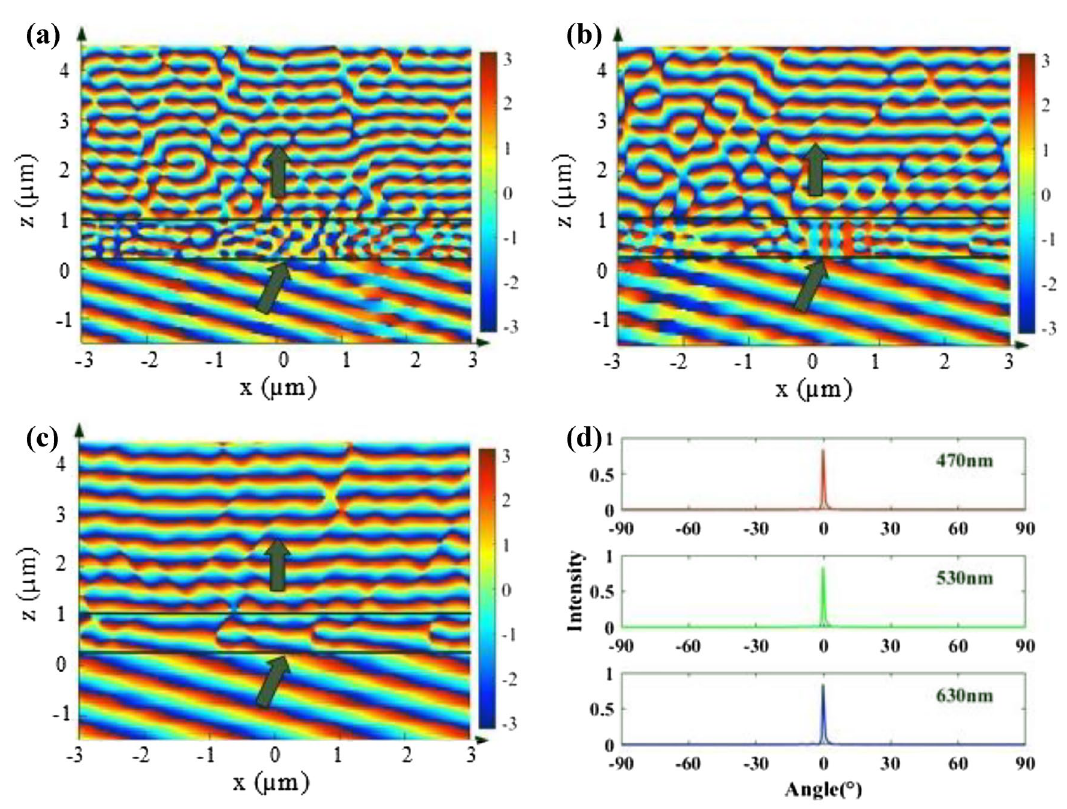
Figure 6. ( a – c ) Part of simulated phase distribution of integrated deflecting layer at the wavelengths of 470 nm, 530 nm and 630 nm, respectively. ( d ) Simulated far-field refraction angles at different working wavelengths under 20° incidence